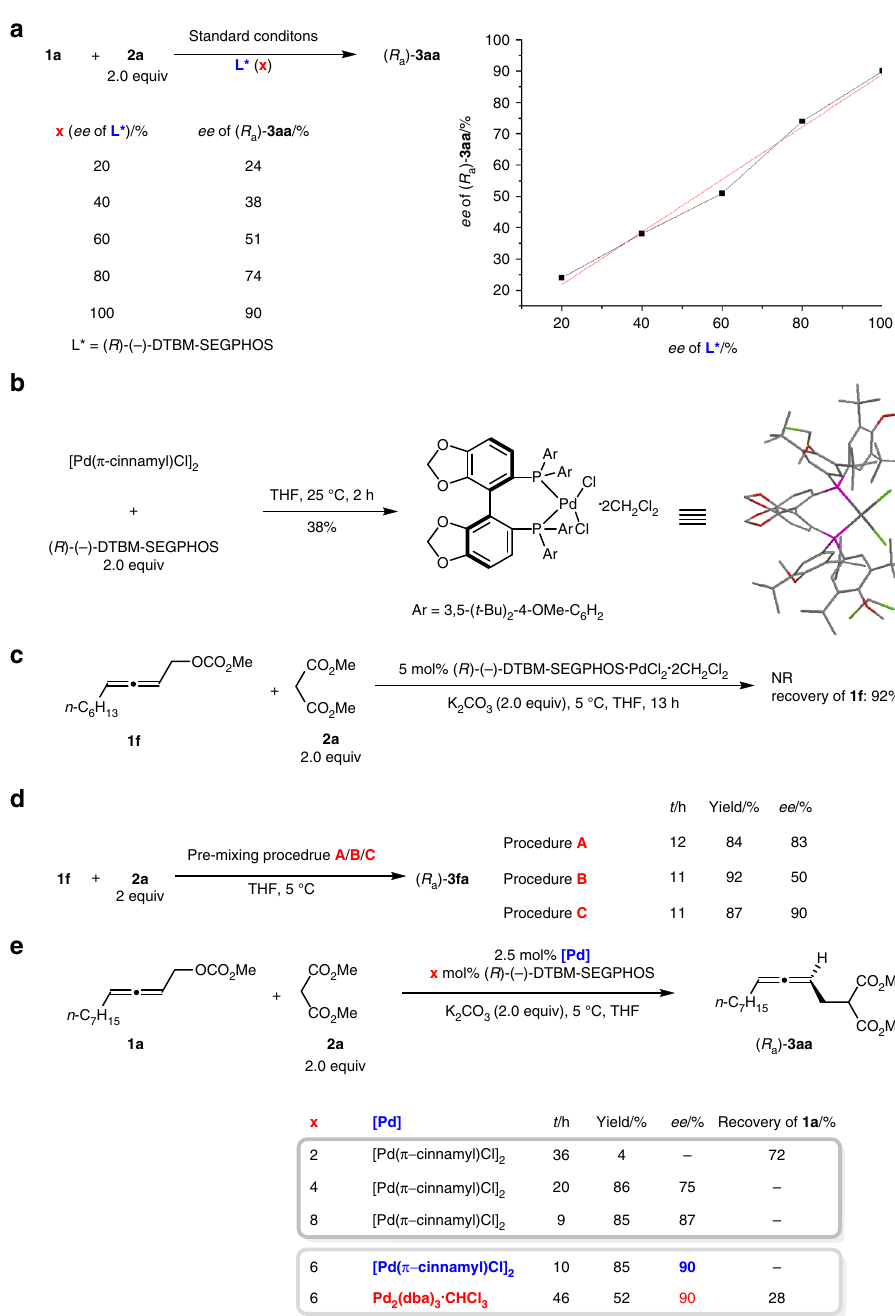
Fig. 5 The studies on reaction mechanism. a The linear effect; b the complex formed from the Pd source and ligand; c the catalytic activity of this complex; d the effect of premixing; e con fi rming the role of the allene unit in the starting